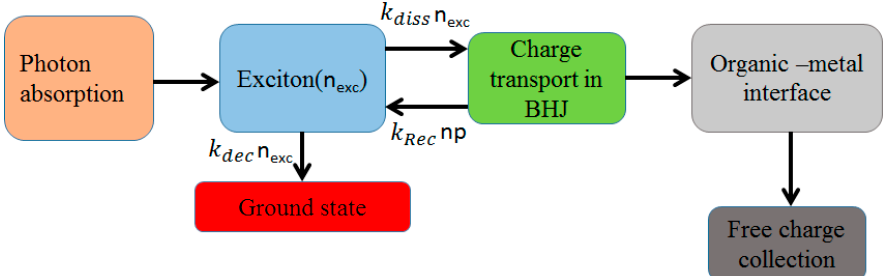
Figure 7. Schematic of the modified model by including exciton state.